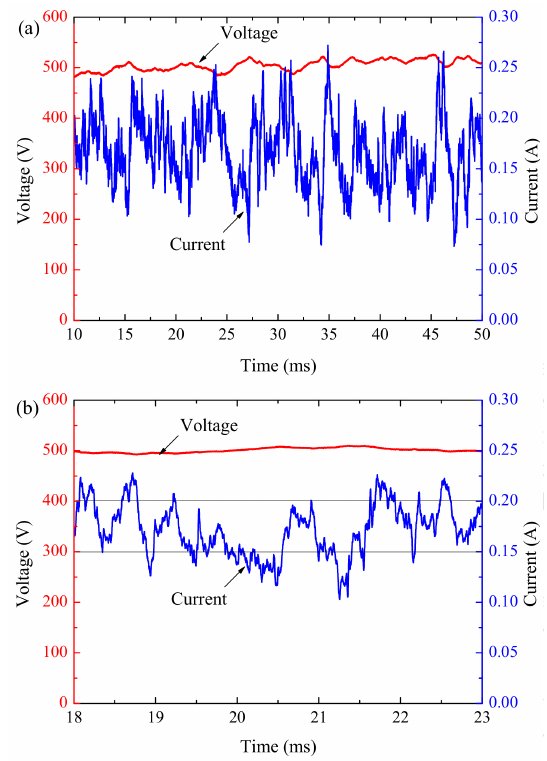
Figure 7. Voltage and current waveforms acquired during anodizing with 500 V / 50 ms pulse, at ( a ) low resolution (period of 40 ms) and ( b ) high resolution (period of 5